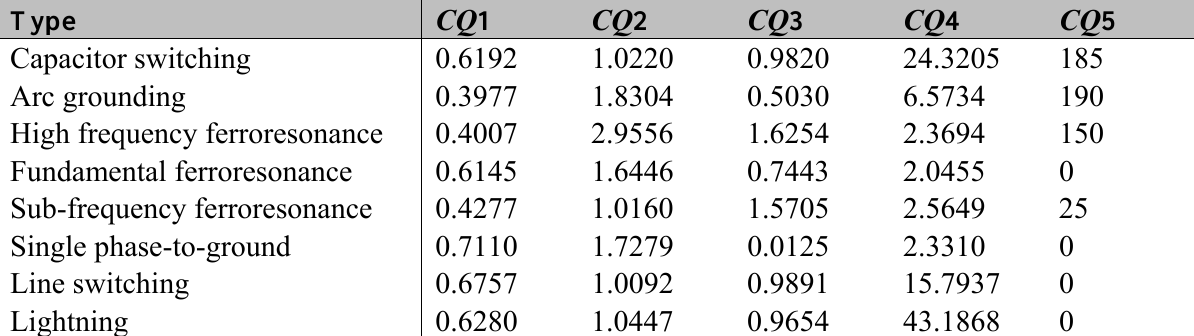
Table 1. The first to fifth characteristic quantities.